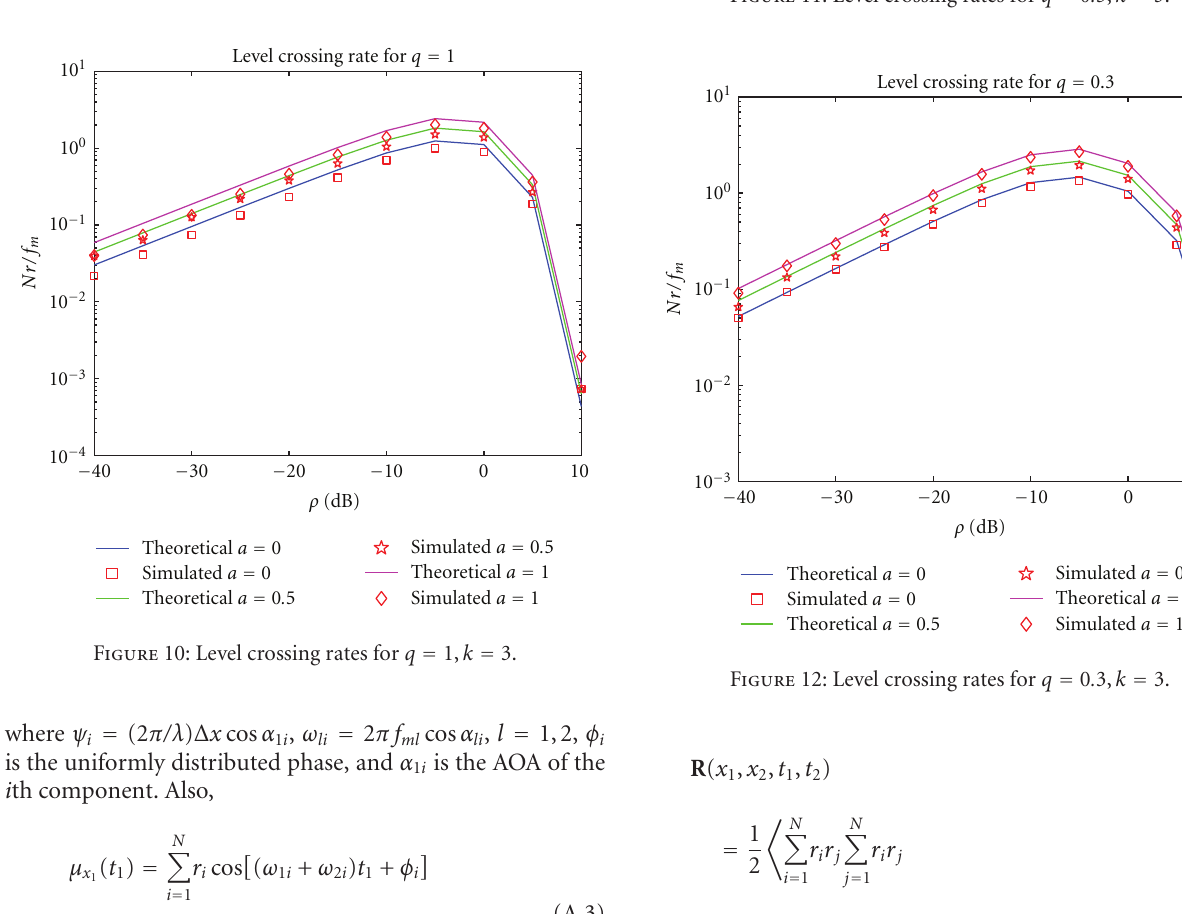
Figure 11: Level crossing rates for q = 0 . 5, k = 3.